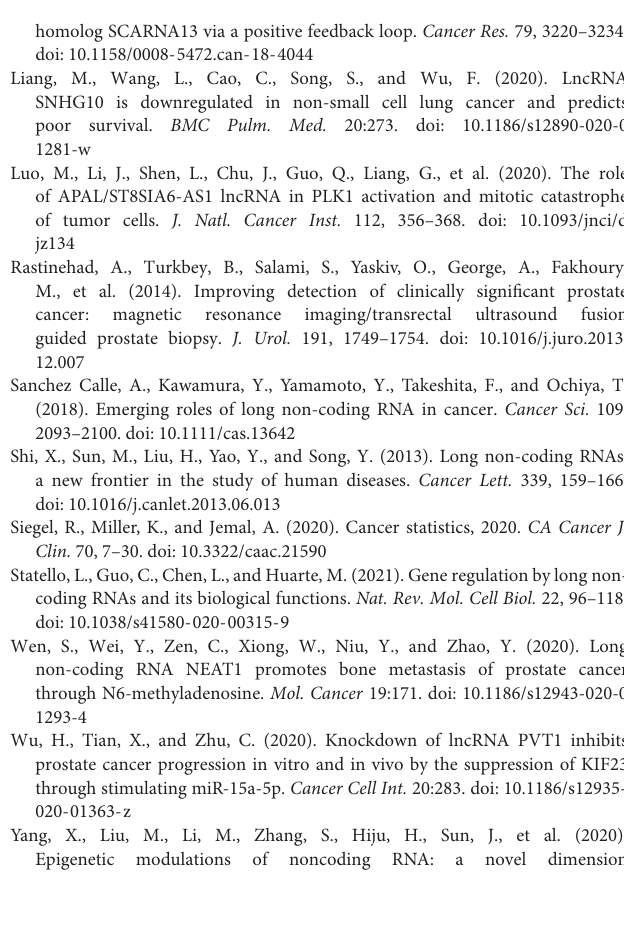
Supplementary Figure 1 | The correlation between SNHG10 expression and the immune infiltration in the tumor microenvironment. (A) Differences in pDC infiltration between SNHG10 low and high expression groups. (B) Correlation between SNHG10 expression and pDC. (C) Differences in NK CD56bright infiltration levels in SNHG10 low and high expression groups. (D) Correlation between SNHG10 expression and NK CD56bright. NK, natural killer; pDC, plasmacytoid dendritic cell. ∗ P < 0.05 and ∗∗∗ P <